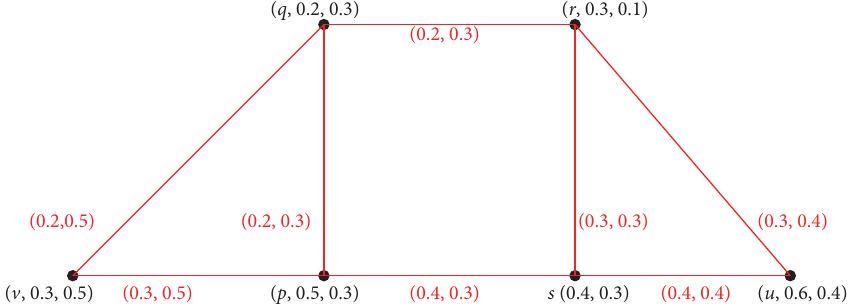
Figure 1: An IFG indicating the network of six different countries.